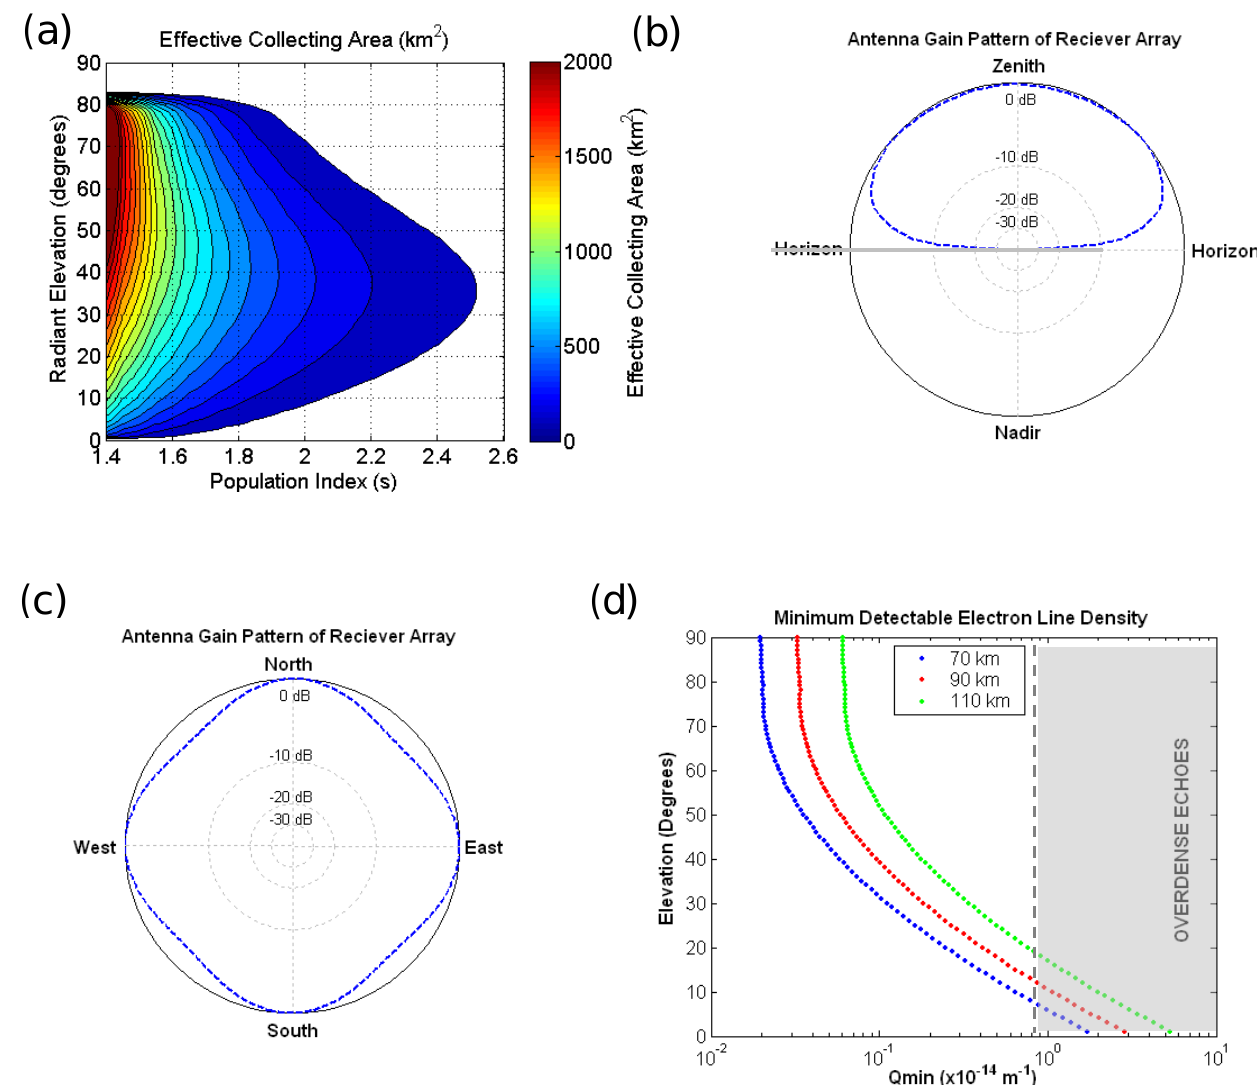
Fig. 1. (a) The Effective radar collecting radar area as a function of source elevation for the Esrange radar. (b) The polar diagram with respect to elevation, and (c) the polar diagram with respect to azimuth, of a receiving antenna used at Esrange, Ascension Island and Rothera. (d) The minimum detectable electron line density as a function of elevation for a 6kW system for meteor velocities of 25kms − 1 at heights of 70km (blue dots), 90km (red dots) and 110km (green